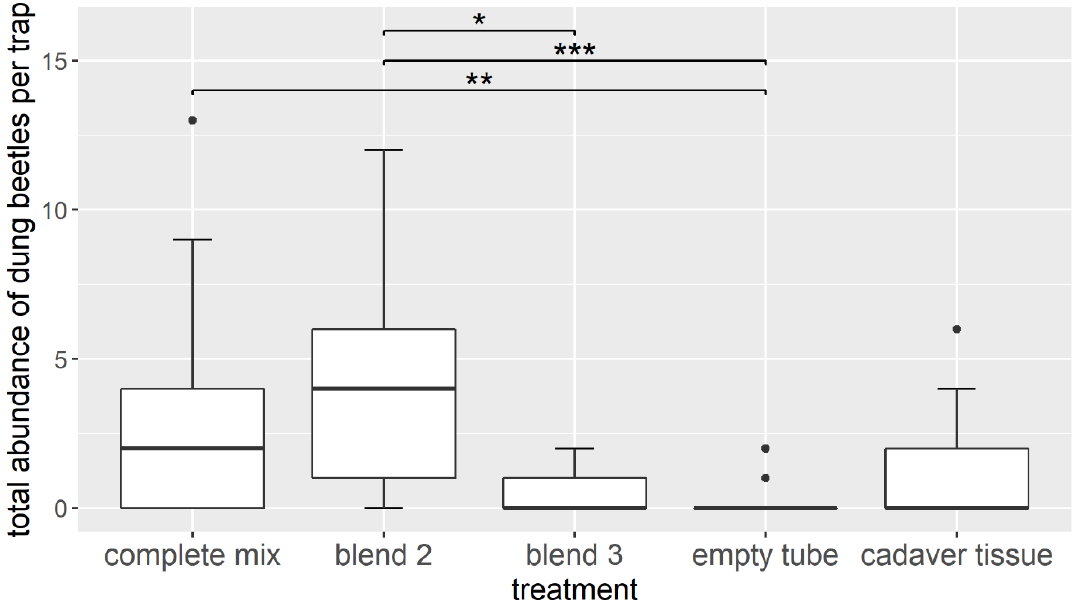
Figure 4. Comparison of the abundance of attracted Anoplotrupes stercorosus individuals among the di ff erent treatments (complete mix: all six EAD active compounds (benzaldehyde, dimethyl trisulfide, 3-octanone, 6-methyl-5-hepten-2-ol, nonanal, and dodecane), blend 2: three EAD active compounds (benzaldehyde, dimethyl trisulfide, and 3-octanone), blend 3: three EAD active compounds (6-methyl-5-hepten-2-ol, nonanal, and dodecane), empty tube: negative control, cadaver tissue: positive control). Each box shows the median, 75% percentile, 25% percentile, and highest and smallest non-extreme value within a category, and asterisks indicate significant di ff erences between treatments (Kruskal-Wallis test: χ 2 = 31.077, df = 4, p < 0.001; post-hoc Nemenyi tests ( p < 0.05): blend 2 vs. blend 3: p = 0.002, complete mix vs. empty tube: p = 0.005, blend 2 vs. empty tube: p < 0.001; significance levels: ns ( p > 0.05), * p ≤ 0.05, ** p ≤ 0.01, *** p ≤ 0.001 ).